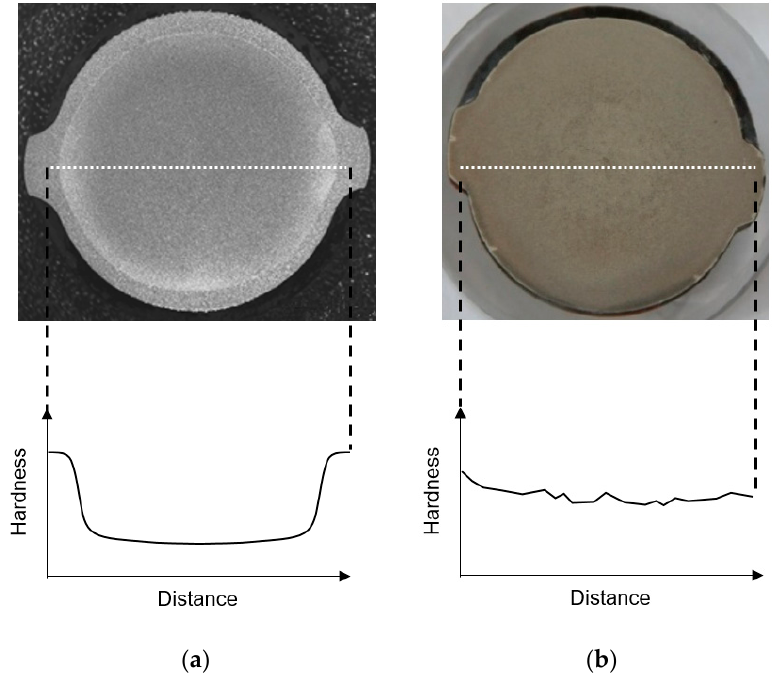
Figure 2. Comparison of hardness profiles of rebars after Tempcore treatment and 5 s water quenching.